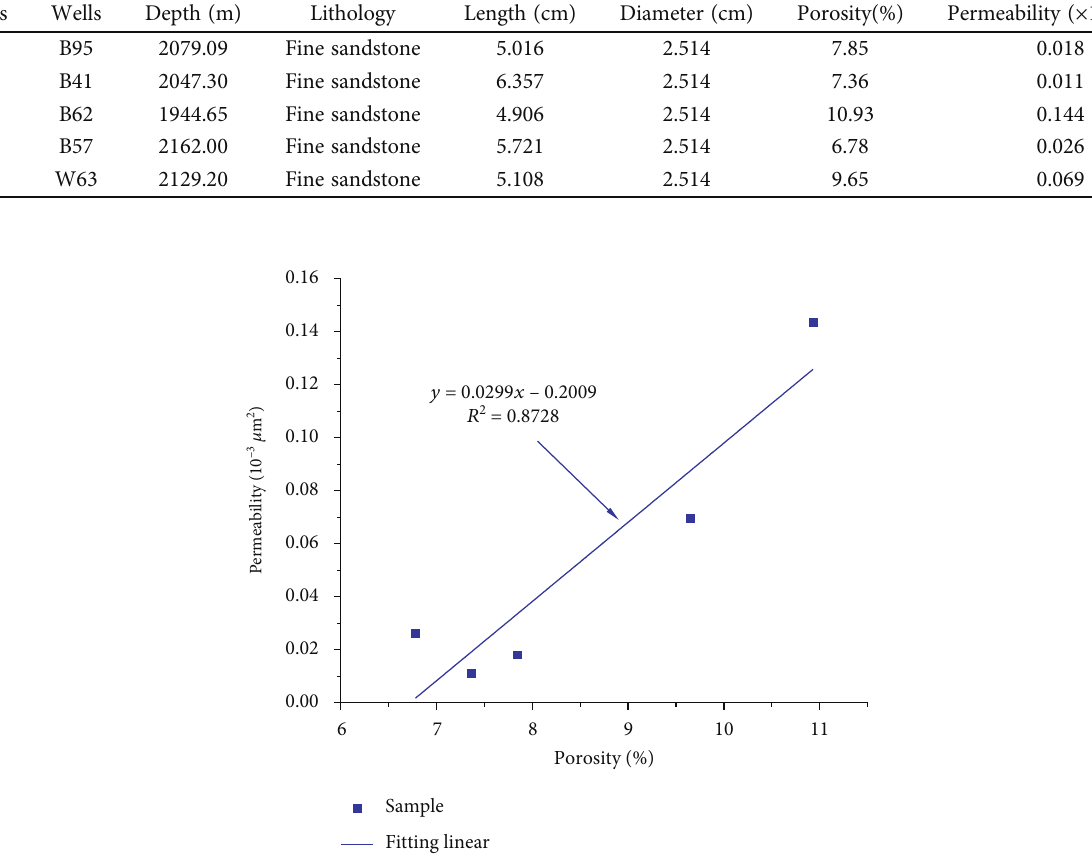
Figure 2: Plots of porosity and permeability correlations for samples from the Chang 7 member of the study